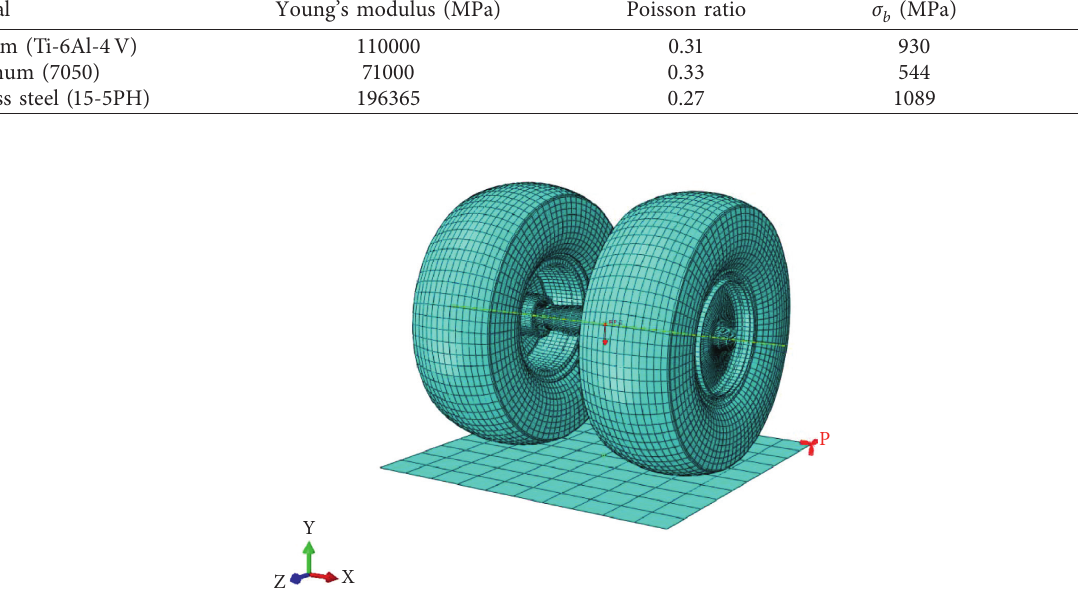
Figure 2: Model of landing gear